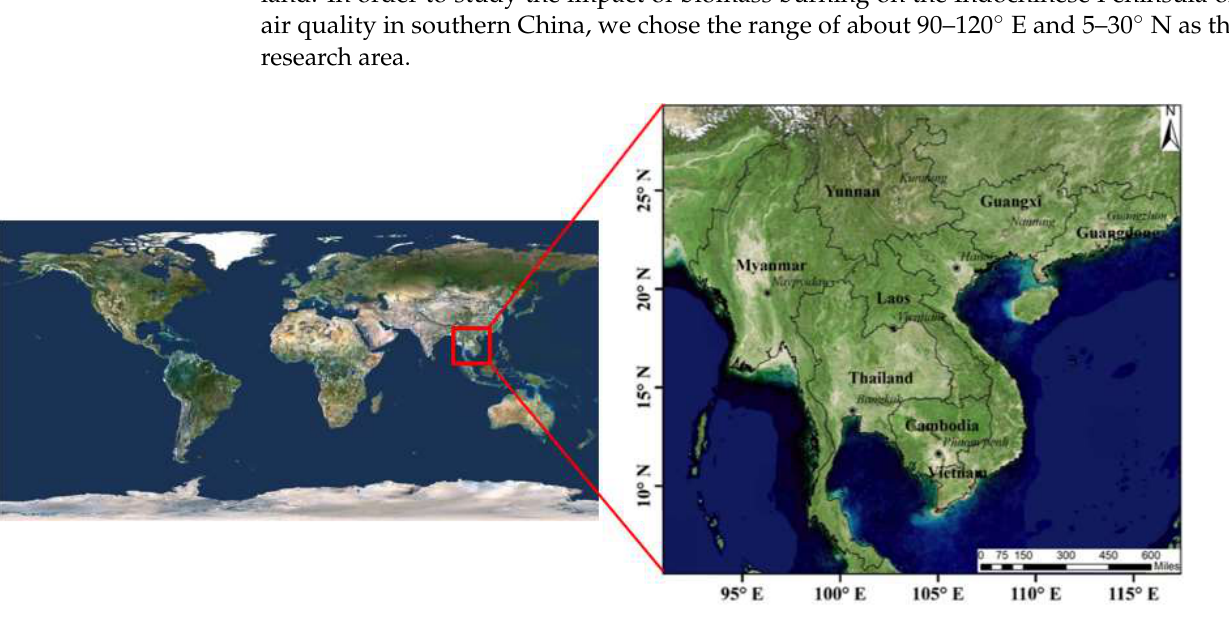
Figure 1. Overview of the study area (90–120° E, 5–30° N).